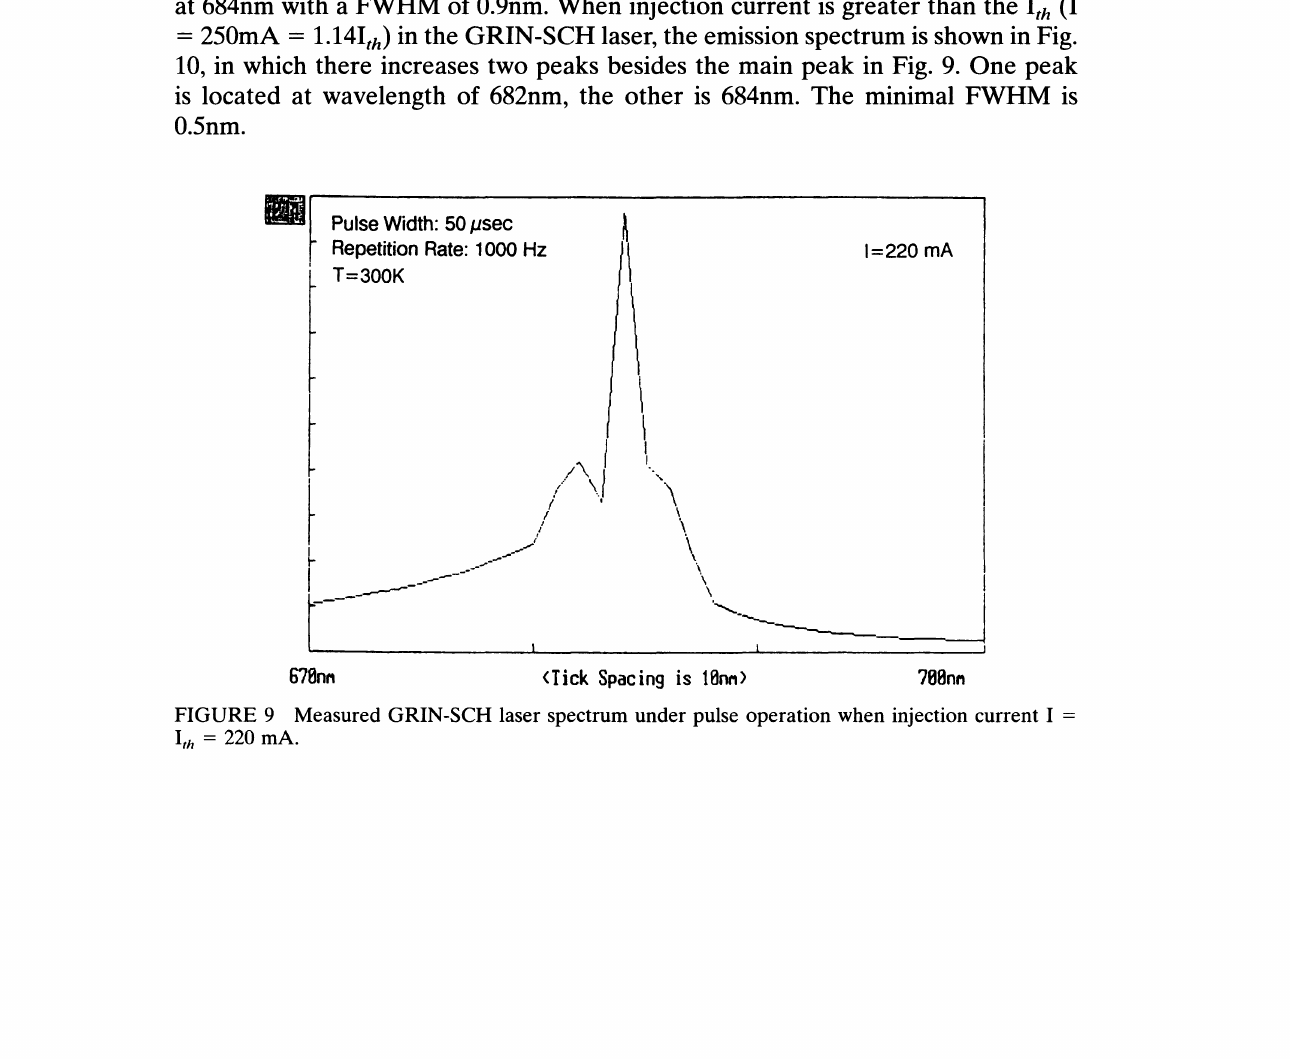
FIGURE 8 Measured DH laser spectrum under pulse operation when injection current I,h 50 mm.